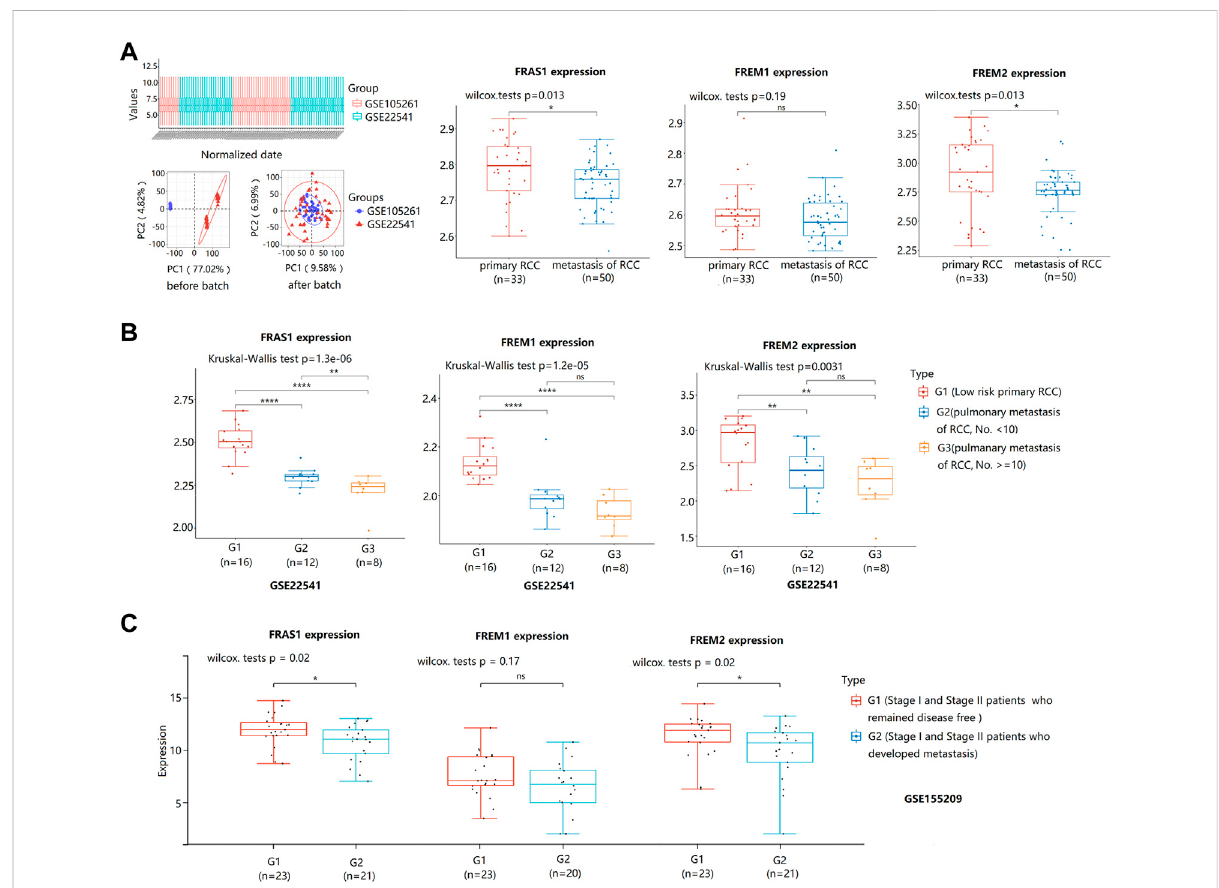
FIGURE 6 FRAS1/FREM mRNA expression between primary KIRC and matestasis of KIRC with datesets from GEO datebase. (A) FRAS1/FREM mRNA expression between primary KIRC and matestasis of KIRC with datesets from GEO datebase (GSE105261 and GSE22541) (* p < 0.05, ns, not statistically signi fi cant). (B) FRAS1/FREM mRNA expression in three groups: The low matestasis risk primary RCC ( n = 16), pulmonary metastasis of KIRC, the number of matastases < 10 ( n = 12), pulmonary metastasis of KIRC, the number of matastases > = 10 ( n = 8) in KIRC from GSE22541. (** p < 0.01, **** p < 0.0001). (C) FRAS1/FREM mRNA expression between stage I and stage II patients who developed metastasis within 5 years of nephrectomy and patients who remained disease free (* p < 0.05, ns, not statistically signi fi